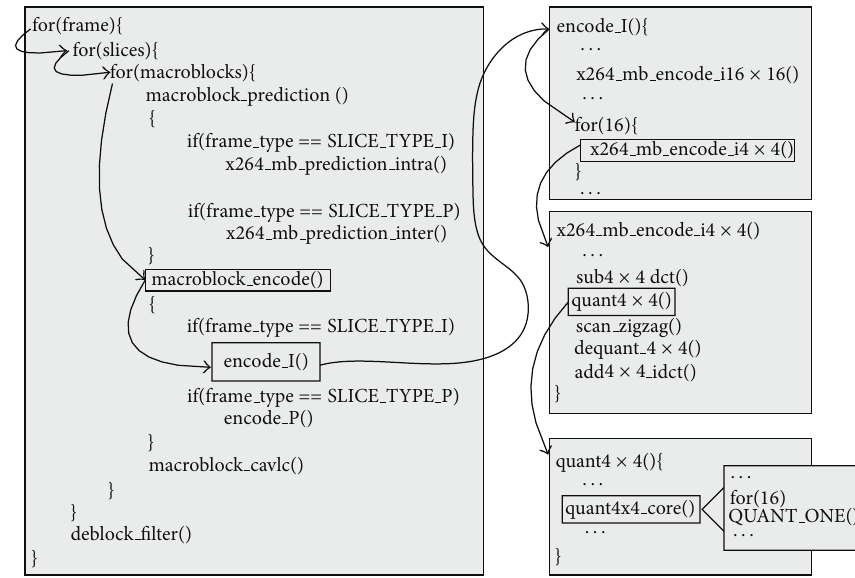
Figure 1: The skeleton of x264